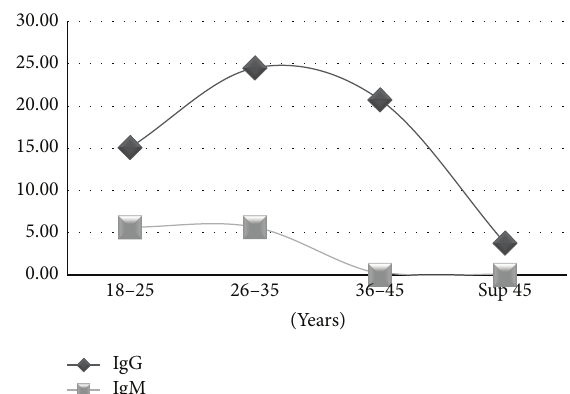
Figure 2: Distribution of Toxoplasma gondii antibodies according to the